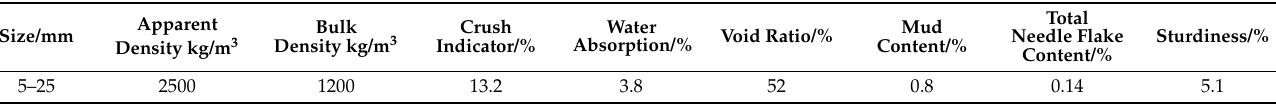
Table 3. Physical properties of recycled